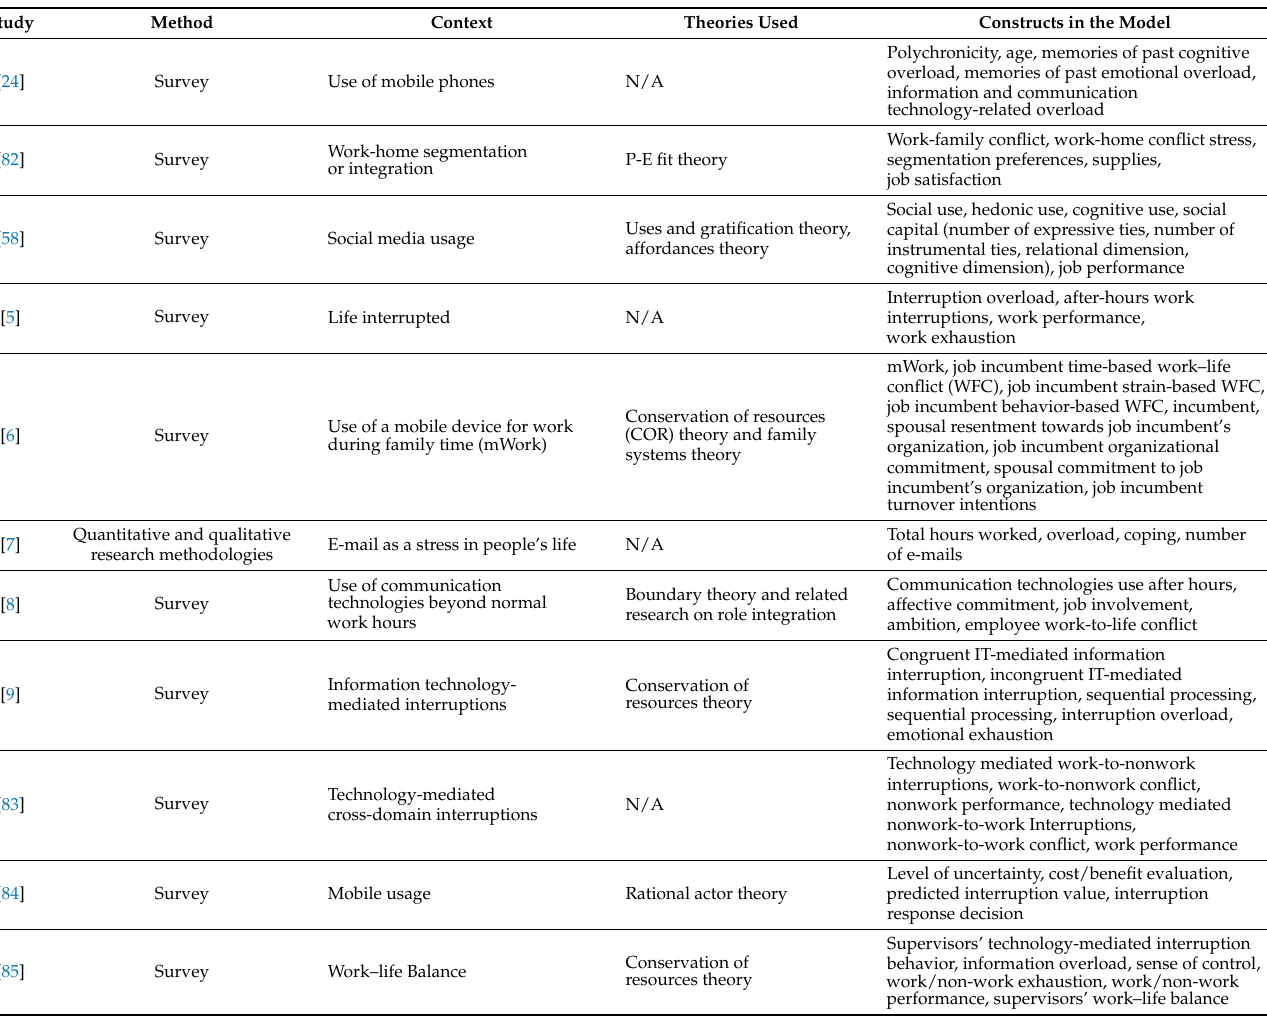
Table A1. Summary of Technology-Mediated Work Interruptions Related